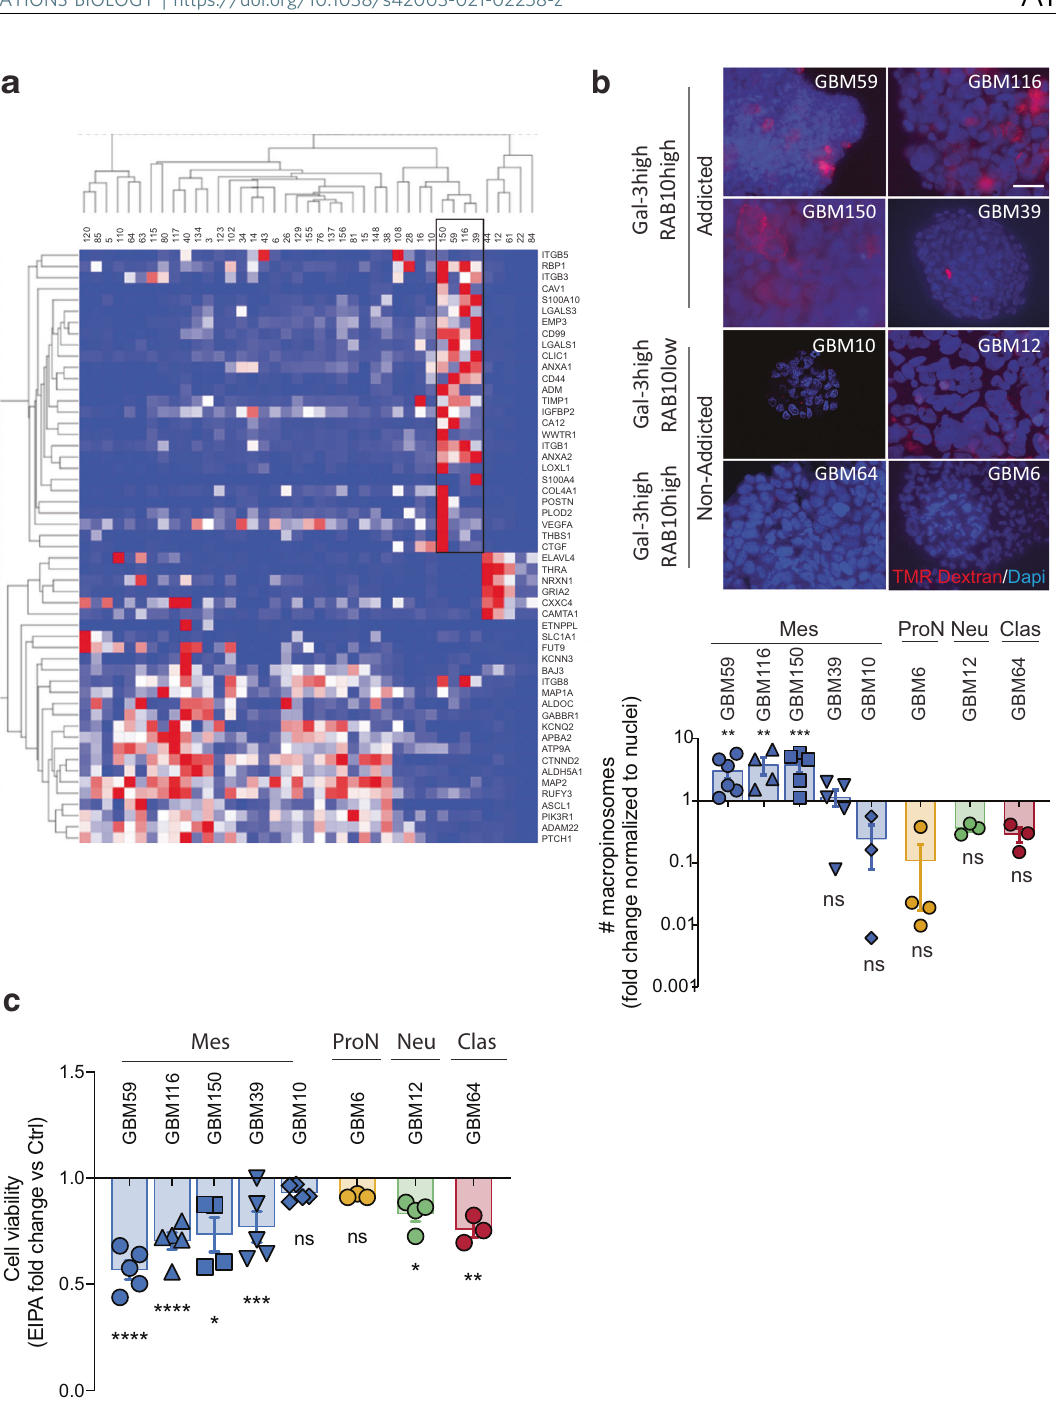
Fig. 6 Macropinocytosis blockade can be predicted by a transcriptomic signature. a Heatmap showing the transcriptomic signature used for the Mayo Clinic sample request. Samples were requested based on their macropinocytosis addicted vs. non-addicted signature. The Black dotted rectangle represents Gal-3/macropinocytosis addicted patients. b Macropinocytosis uptake assay using TMR – dextran in Mayo Clinic GSC samples. Histograms represent the fold change of macropinocytosis activity in all GSCs normalized to nuclei number ( n = 3 – 6). c Effect of EIPA on cell viability measured by CellTiter-Glo in GSCs ( n = 3 – 5). Data are represented as mean ± SEM (* p < 0.05, ** p < 0.01, and *** p < 0.001), two-way ANOVA, Sidak ’ s adjusted p value. ns nonsigni fi cant, Mes mesenchymal, ProN proneural, Clas